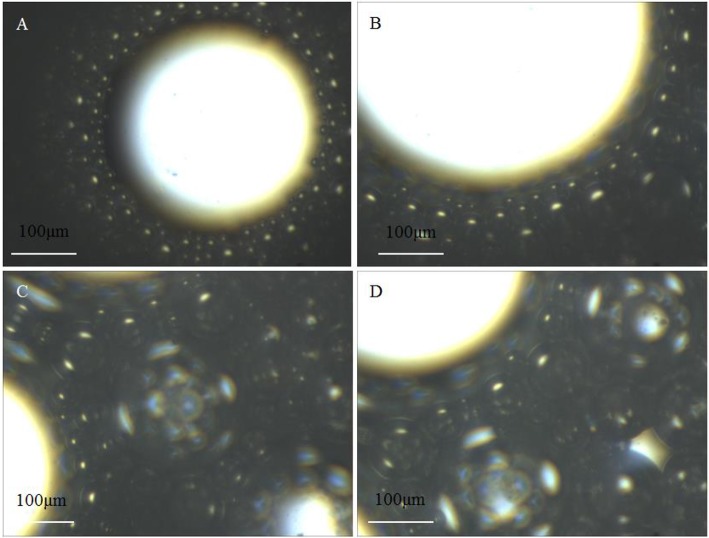
Micrographas of SC-CO2 foams stabilized with 0.05 and 0.5% NPs HHSB at 70°C and 8 MPa aging for 10 min (A), 40 min (B), 70 min (C), and 100 min (D).